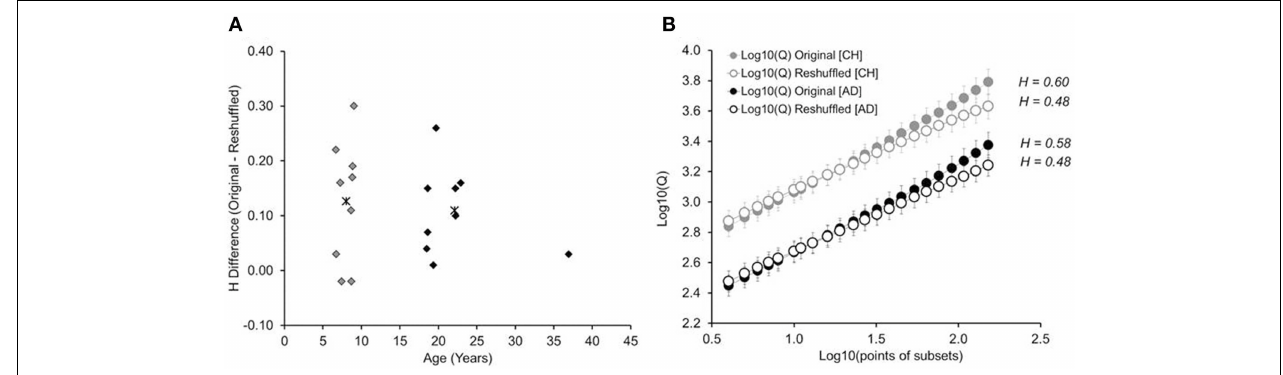
(B) Cumulative plots on log 10 -log 10 coordinates, separated by age group (children, adults), and type of trial series (original and